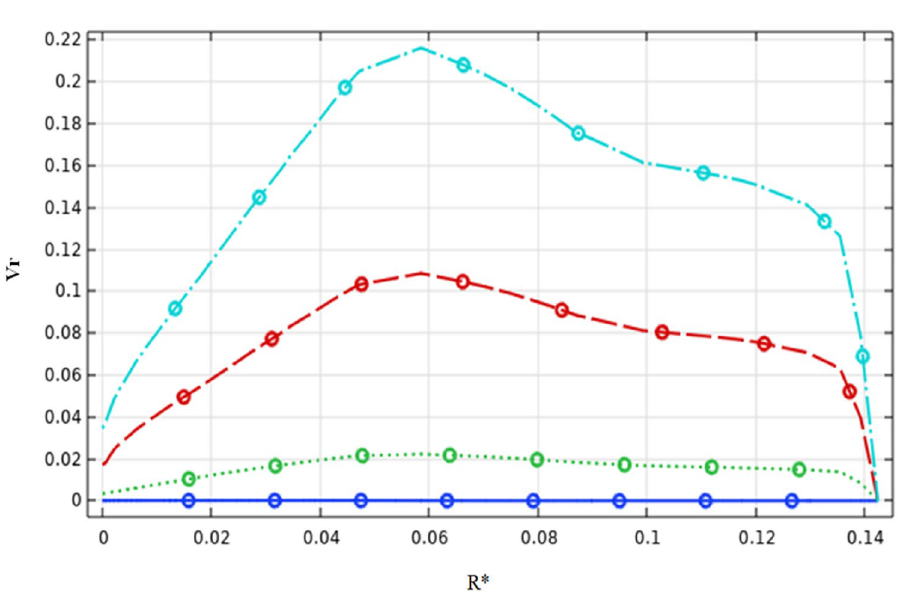
Figure 10. Velocity magnitude distribution Vr in the horizontal median section on the stirred tank for different Reynolds